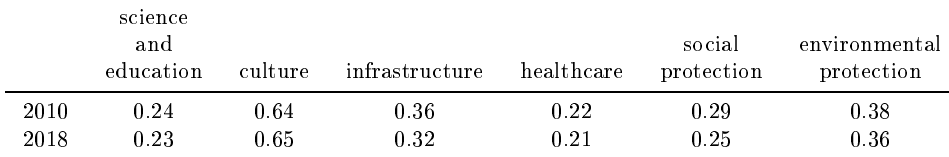
Table 5: Gini coe(cid:30)cients by